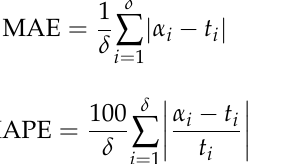
Figure 33. Prediction absolute error percentage of three models.